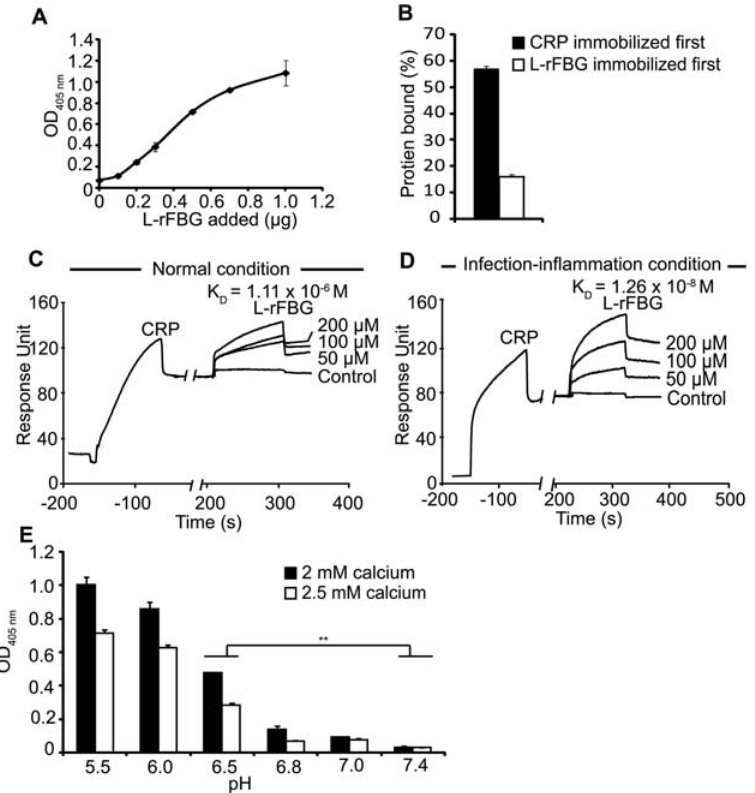
Figure 5. Biochemical characterization of the interaction between CRP and L-rFBG. (A) Dose-dependent binding of L-rFBG to 0.8 m g of immobilized CRP. The indicated amount of L-rFBG in blocking buffer was added to the immobilized CRP. OD 405 nm was read to indicate the binding of L-rFBG to CRP. 0.8 m g of HSA immobilized on the wells instead of CRP was the negative control and readings were subtracted off the negative controls. (B) Effect of the order of immobilization on the binding between CRP and L-rFBG. 0.8 m g of L-rFBG was added to 0.8 m g of immobilized CRP (black bar) and 0.8 m g of CRP was added to 0.8 m g of immobilized L-rFBG (white bar). To compare the data from the two orders of immobilization, the binding proteins (L-rFBG or CRP) directly immobilized on the plate were detected and were taken as 100% binding, to which other readings were normalized against. The affinity between CRP and L-rFBG under normal (C) or infection-inflammation condition (D) was tested by surface plasmon resonance analysis using BIAcore 2000. POPC was immobilized on the HPA chip to expose PC as ligand for CRP. A 50 m l of CRP at 200 nM in the running buffer was injected. Fifty m l aliquots of L-rFBG at the indicated concentrations were injected afterwards. The negative controls involved injection of buffers (without L-rFBG) over the PC-HPA chip immobilized with CRP. Data were analyzed using BIAevaluation 3.2 software. (E) Binding of L-rFBG to immobilized CRP at pH ranging from 5.5 to 7.4, in the presence of 2 mM calcium (black bars) or 2.5 mM calcium (white bars). HSA instead of CRP immobilized on the plates was the negative control and readings were subtracted off the negative